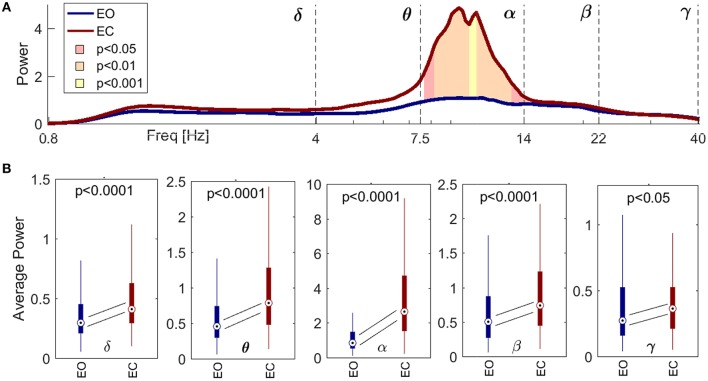
Spectral comparison between signals recorded during the eyes open (EO, red) and eyes closed (EC, blue) conditions, for all the probes from all the subjects. (A) Paired statistical comparison between the inter-probe average power spectra from each subject in EO and EC, respectively. The lines show inter-subject medians, and the ranges of significance are shaded pink for p < 0.05, orange for p < 0.01 and yellow for p < 0.001. (B) Boxplots for the average power within the five frequency intervals. Diagonal lines symbolize statistical analyses pairing corresponding values for every probe and subject, and follow the changes in the medians. The p-value is indicated in each case. Note that the significance of the power in (A) corresponds closely to the boundaries of the α interval, and that the power in (B) increases significantly between EO and EC for every frequency band.